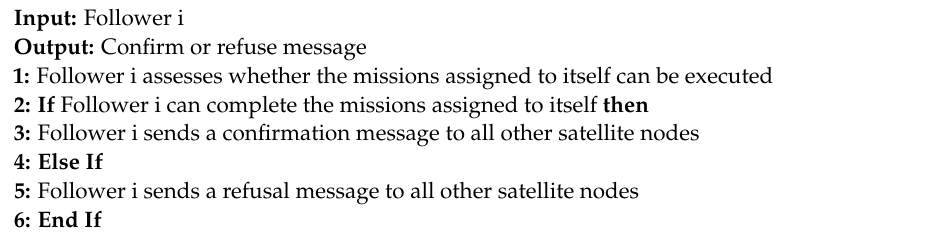
Algorithm 5. The follower block verification behavior of the modified PBFT